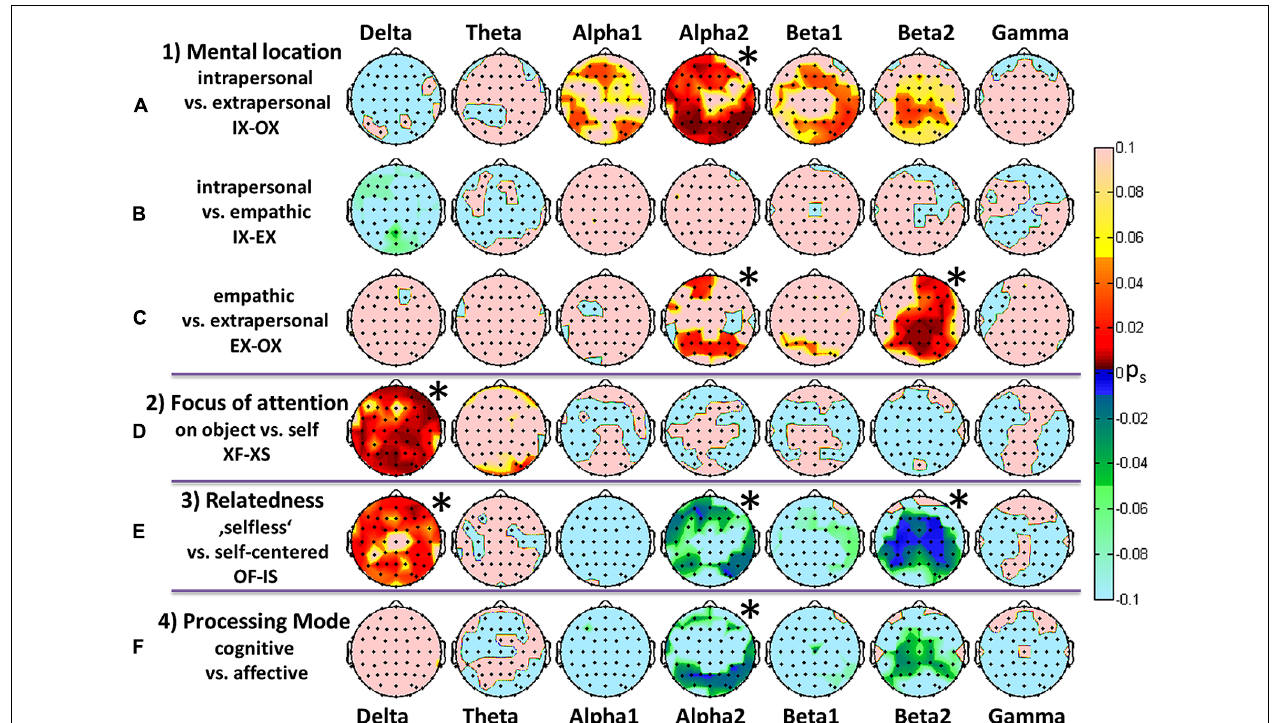
an arbitrary focus. (D) Comparison of attentional foci, i.e., the flowers versus self-directed, independent of the location. (E) Differences between a “selfless” and a self-centered mind set reflected by a change in both position and focus. (F) Contrast between mental processing modes.The asterisks indicate overall significance according to Figure 2